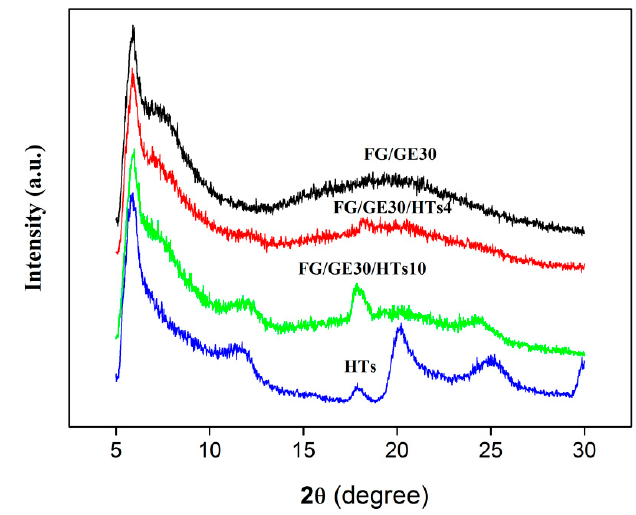
Figure 4. XRD patterns of HTs and FG/GE30 at 0, 4 and 10 wt %.